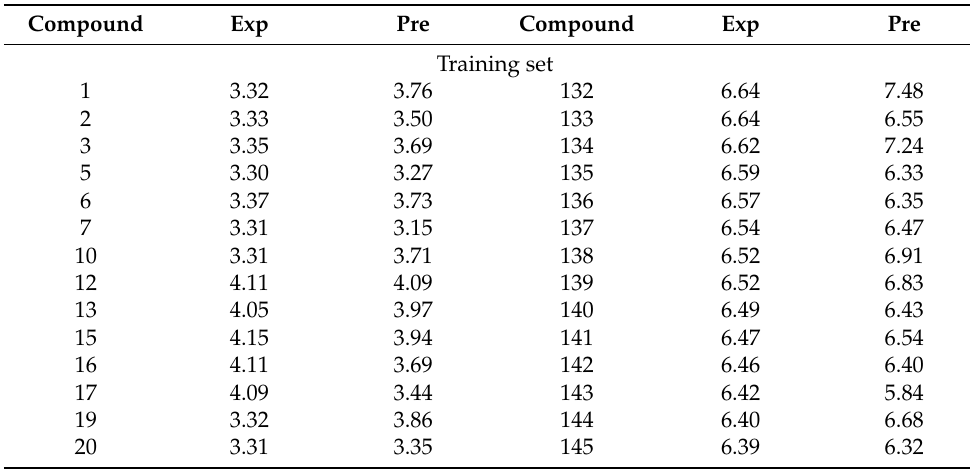
Table 3. Experimental and predicted pIC 50 for Topomer CoMFA Model 2.